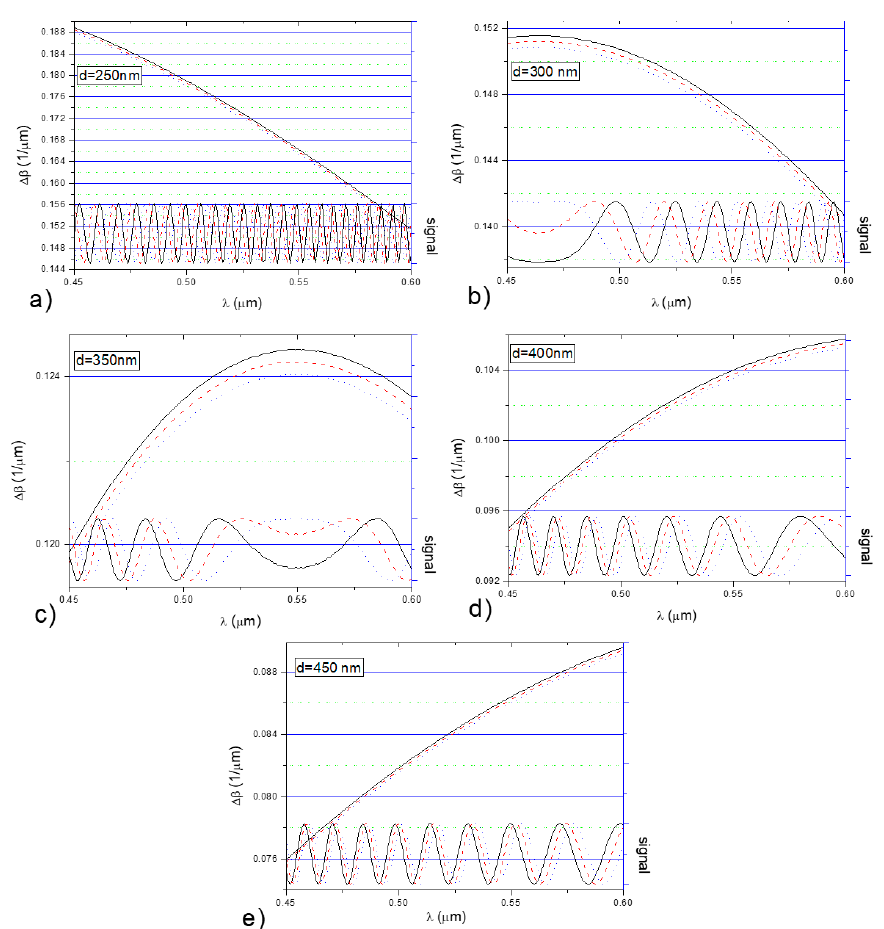
Figure 8. Impact of the cover refractive index change on the functions Δ β (left axis) and the output signal (right axis) of the system (for the propagation path length of 4mm), and waveguide thickness: ( a ) 250 nm, ( b ) 300 nm, ( c ) 350 nm, ( d ) 400 nm, ( e ) 450 nm. (Solid black line for n c 1 ( λ ) = n H2O , red dash line for n c 2 ( λ ) = n H2O ( λ ) + 0.001, blue dot line for n c 3 ( λ ) = n H2O ( λ ) + 0.002.)